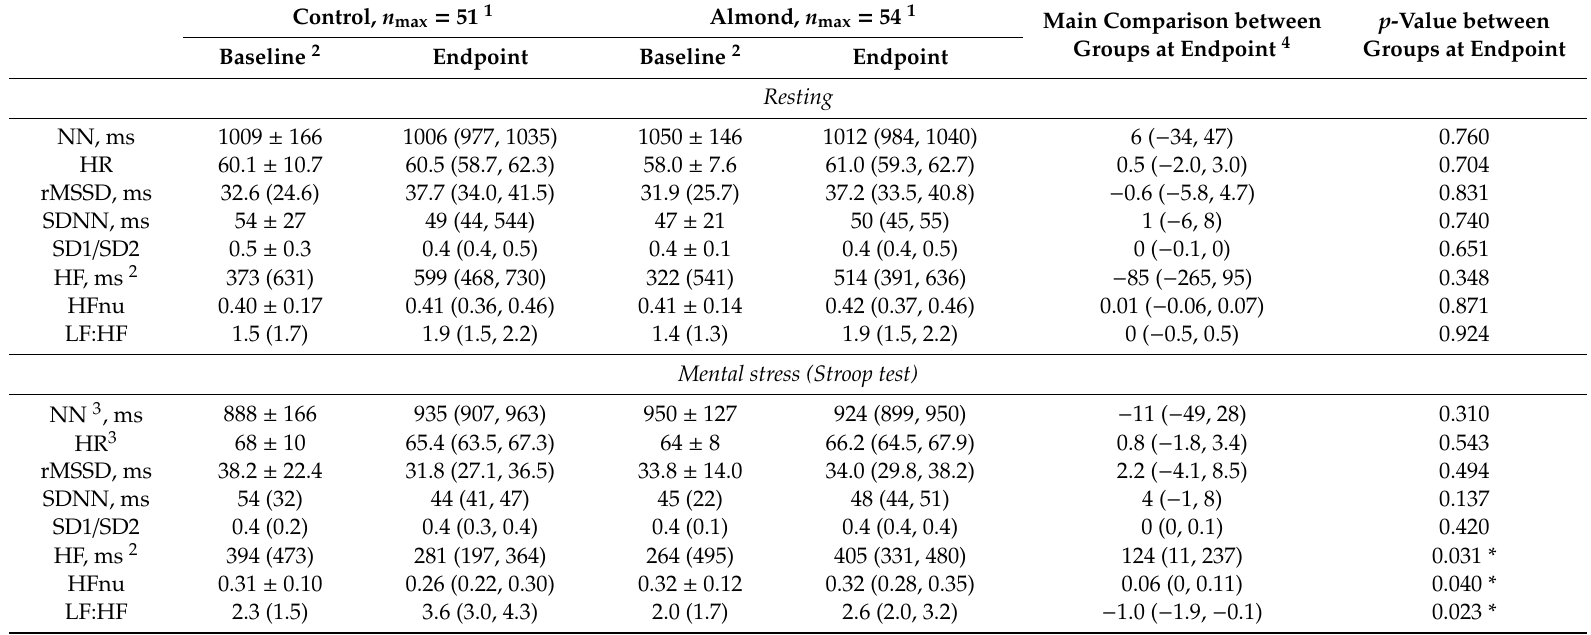
Table 3. Heart rate variability values measured during 5-min periods of rest and mental stress (Stroop test), following randomization to almond and control snacks. Control, n max = 51 1 Almond, n max = 54 1 Main Comparison between